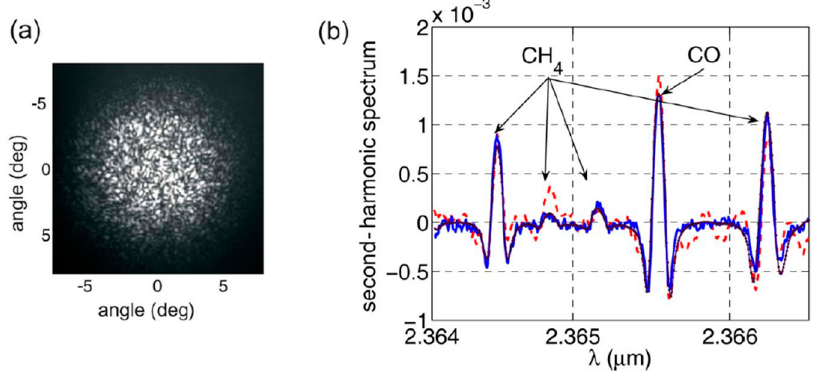
Figure 4. ( a ) A far field of the hollow waveguide / fiber used in [20]. Speckle pattern indicates multimode propagation inside HCF. It led to the presence of optical fringes in the recorded spectra, which could be washed out by applying vibration to the fiber; ( b ) wavelength modulation spectroscopy (WMS) spectra (second harmonic signal) measured with and without vibration of the fiber (blue / solid and red / dashed curves, respectively). Also shown is the simulated / theoretical spectrum (black / dotted). Reprinted with permission from [20], © The Optical Society.